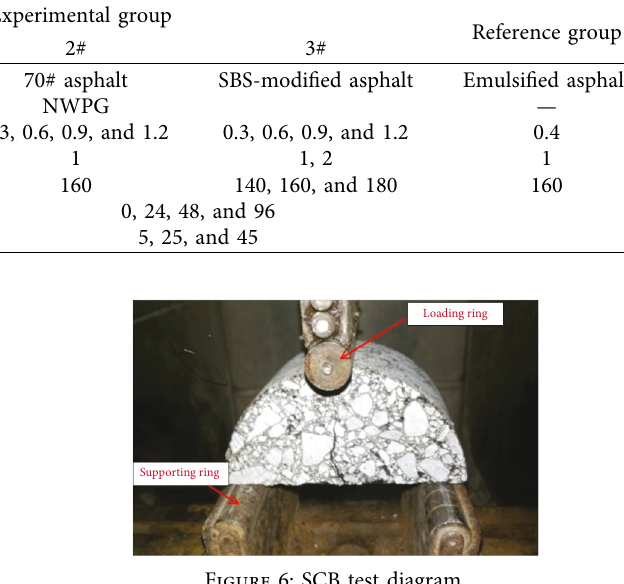
Figure 4: Layer-parallel direct shear test. (a) Test device; (b) load-displacement typical Table 4: The experiment program for the direct-shear test.